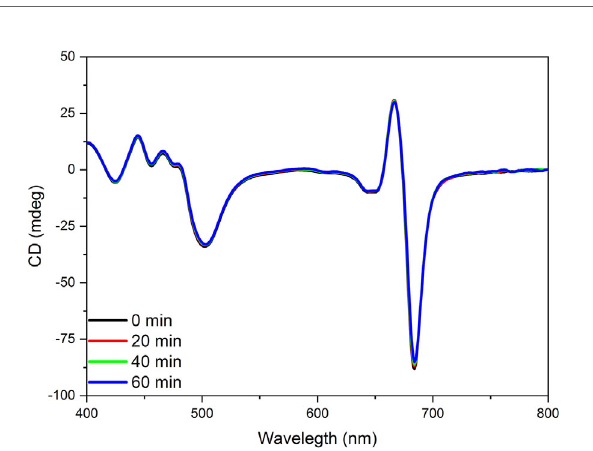
FIGURE 9 | CD spectra of untreated (0 min) and 2 M NaSCN treated LHCII microcrystals at different times after the start of the treatment, as indicated. The spectra are normalized to the red absorbance maximum [OD(680 nm) =1.0] of the untreated samples. Note that the 0, 20, 40, and 60 min traces overlap. Three independent biological replicates were measured and a typical data set is